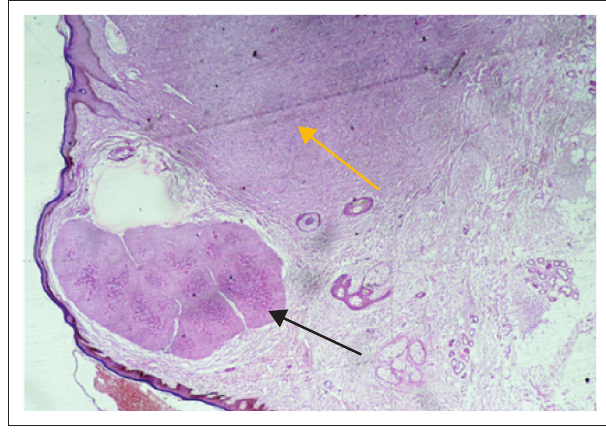
FIGURE 3: Low power view of the coexisting Kaposi sarcoma (golden arrow) and Molluscum contagiosum (black arrow). Haematoxylin and eosin staining X 40.